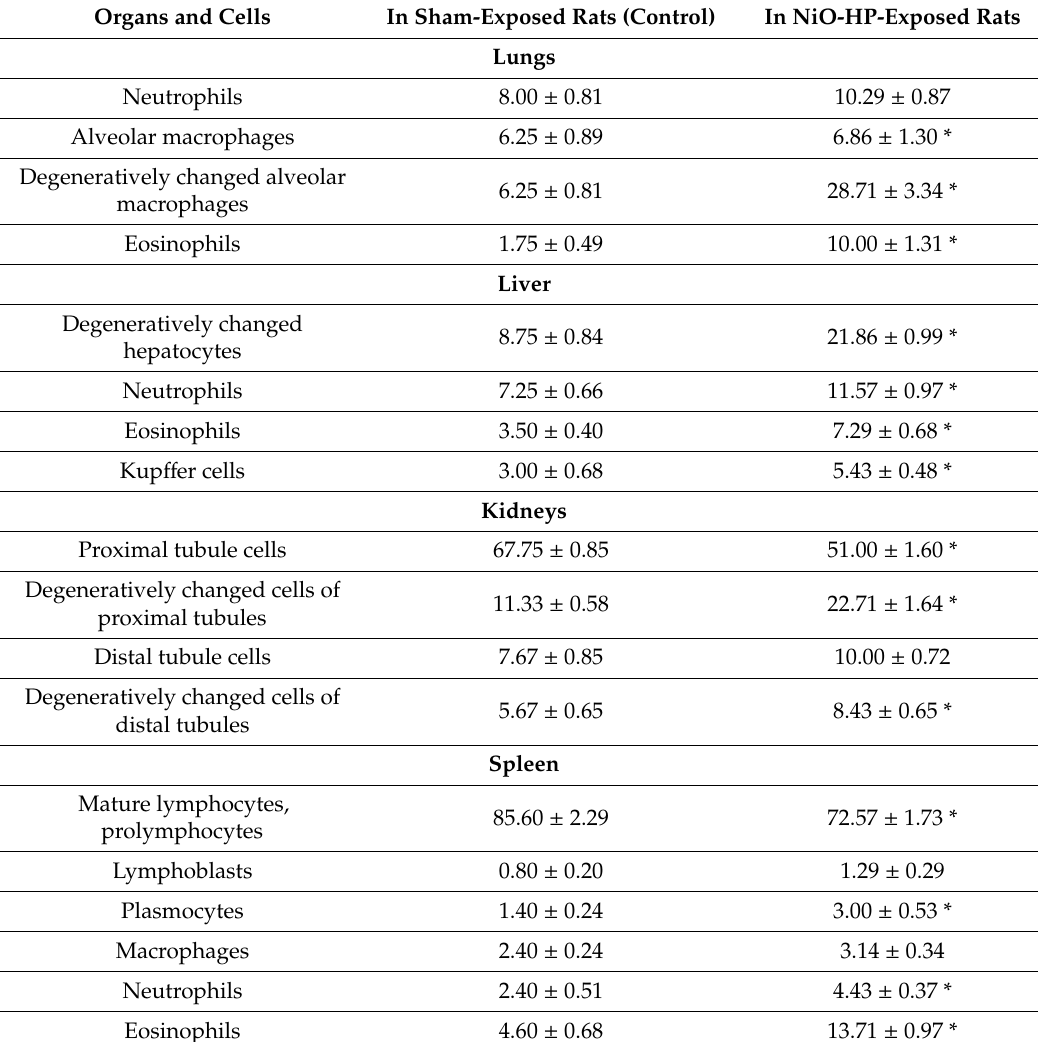
Table 3. Some cytological characteristics of di ff erent organ imprints from rats sacrificed on the next day after the fifth 4 h inhalation exposure to NiO-NPs at a 1.0 ± 0.1 mg / m 3 concentration; percentage of total cell count ( x ± s.e.